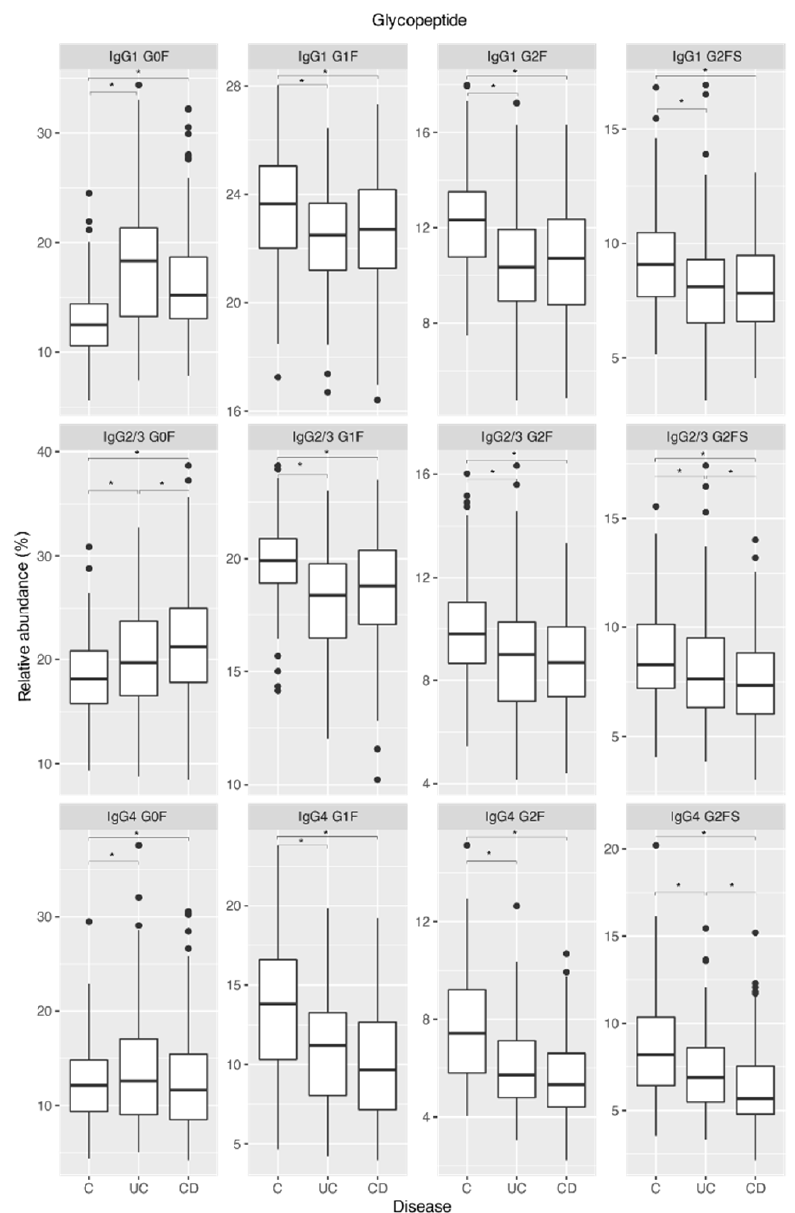
Figure 1. IgG Fc-glycan patterns in controls, patients suffering from ulcerous colitis, and patients suffering from Crohn’s disease (Cohort 1 at baseline) for all IgG subclasses. Each box represents the 25th to 75th percentiles (interquartile range—IQR). Lines inside boxes stand for the median. The whiskers are the lowest and highest values within boxes ± 1.5 × the IQR. Dots are outliers (>1.5 × IQR). Significant differences ( p < 0.05) are marked with an asterisk *. Normalized size effect and p -values are given in Table S1. C—controls; UC—ulcerous colitis; CD—Crohn’s disease.